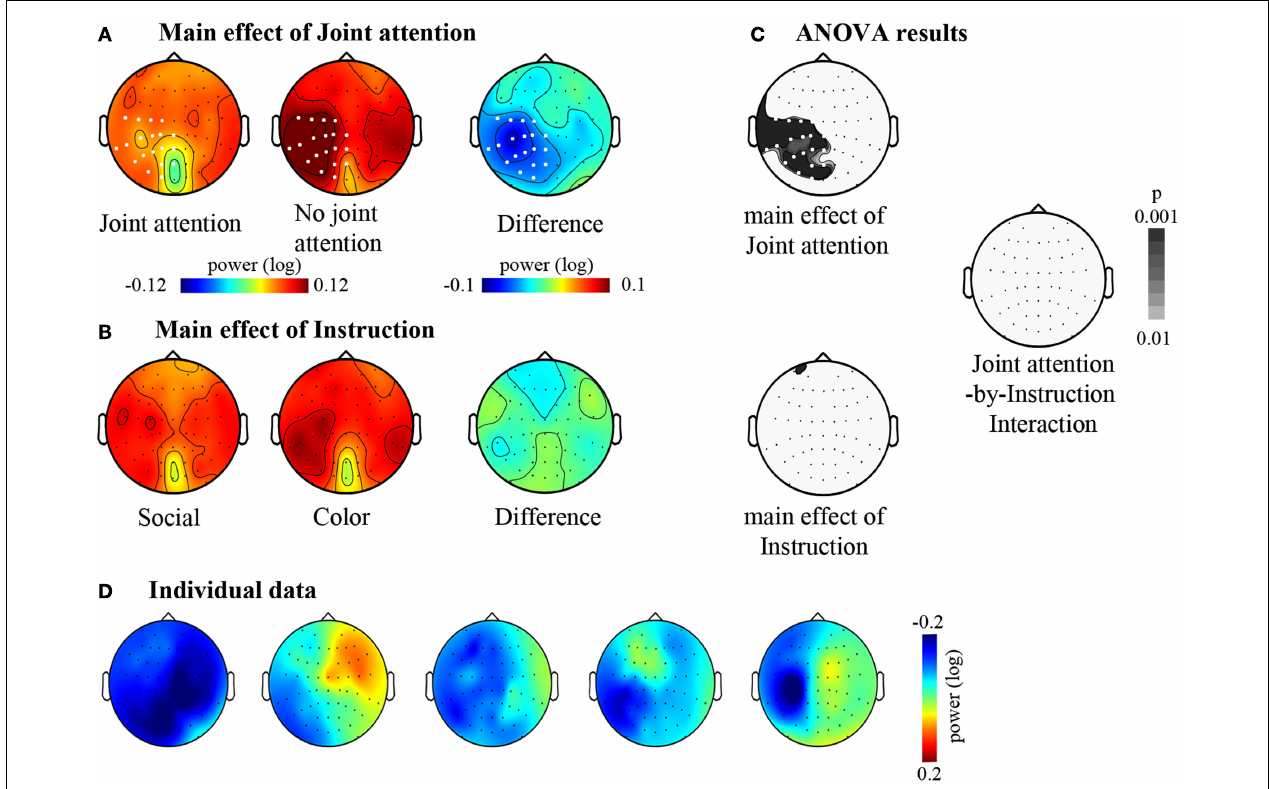
is represented on a top view of the head. (C) Results of the two-by-two ANOVA with Joint attention and Instruction as within-subject factors.The maps (top views of the head) of the p -values for the main effects of Joint attention and of Instruction are represented, as well as the map of the p -values for the interaction between Joint attention and Instruction. For (A,C) , electrodes for which the p -value was beyond 0.01 ( p < 0.01) are represented in white.There was not any electrode yielding a significant effect of Instruction or an interaction between Joint attention and Instruction. (D) Illustration of the main effect of Joint attention in five example subjects. Difference maps between Joint and No- joint attention conditions are